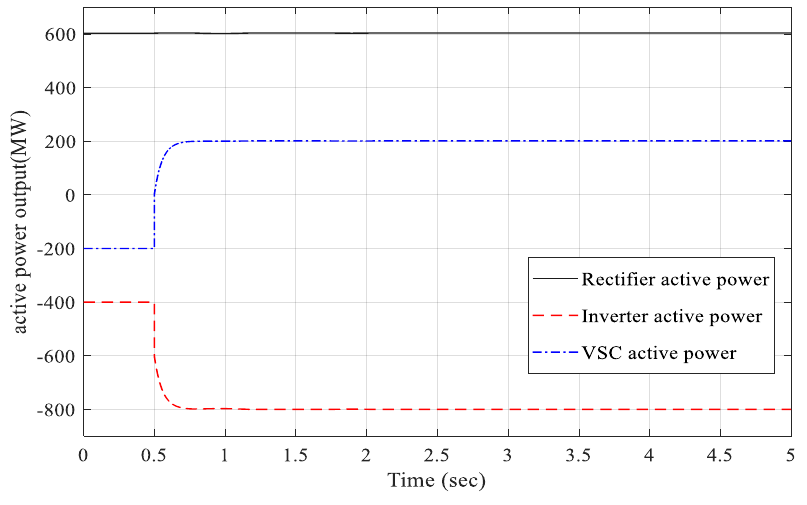
Figure 8. The active power for each converter.